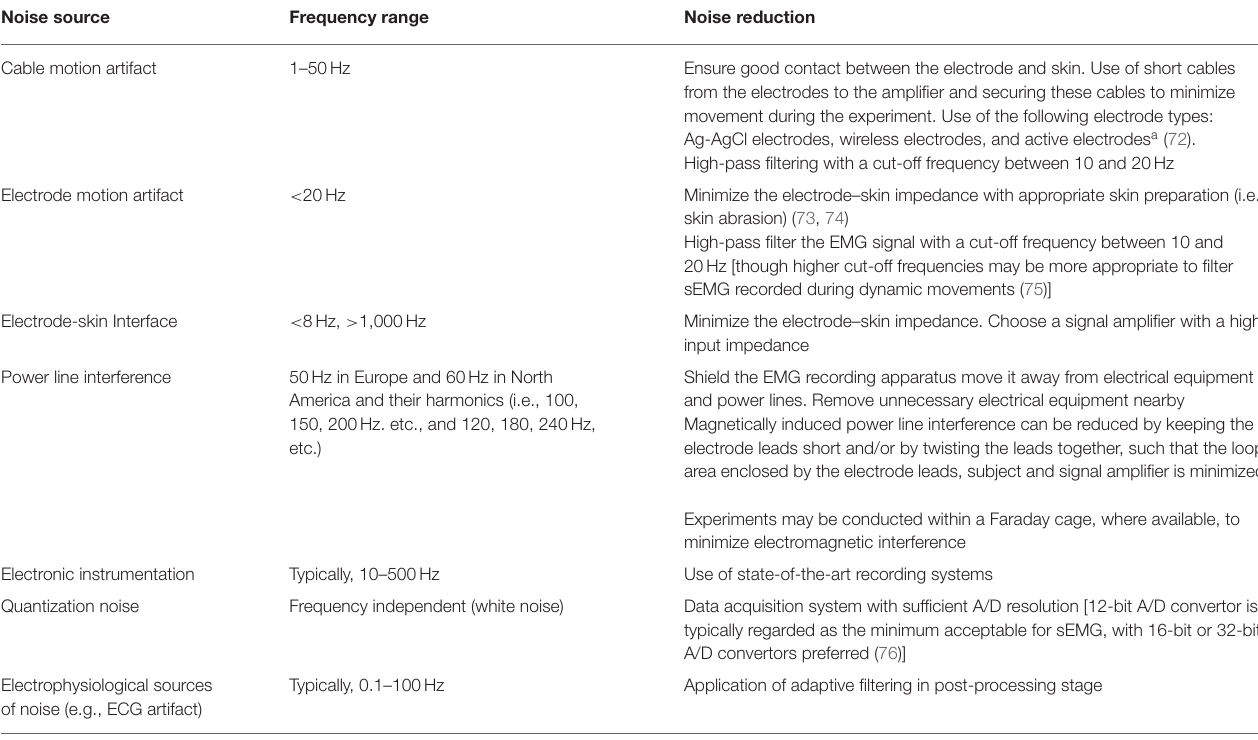
TABLE 3 | Sources of noise in the EMG